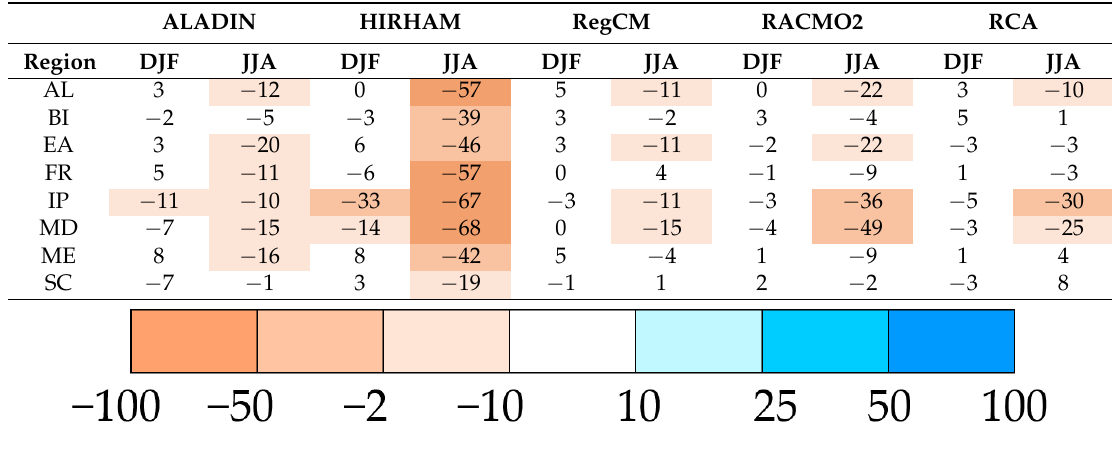
Table 4. Residual bias in the seasonal amount of simulated precipitation (a) in the case of gpQM bias correction in eight different regions: the Alps (AL), the British Isles (BI), Eastern Europe (EA), France (FR), the Iberian Peninsula (IP), the Mediterranean (MD), Mid-Europe (ME) and Scandinavia (SC) in DJF and JJA. The bias values are in